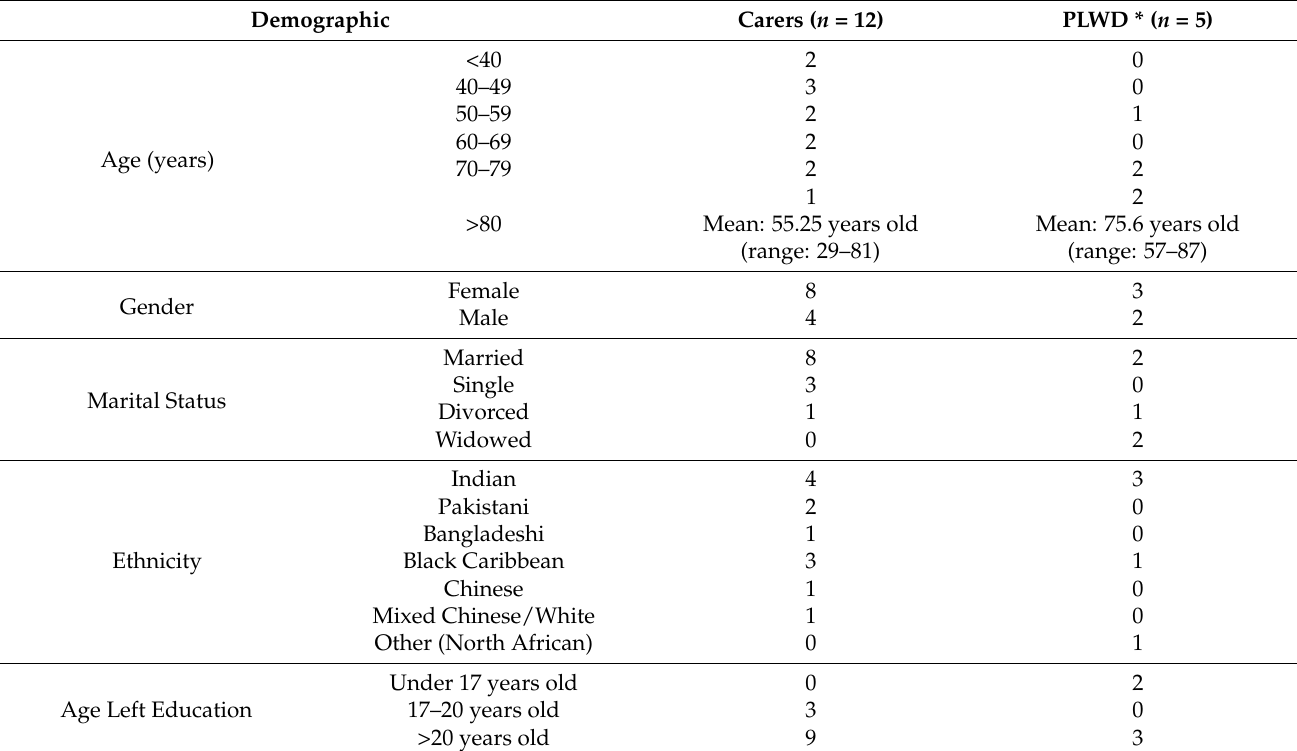
Table 2. Demographic Characteristics of